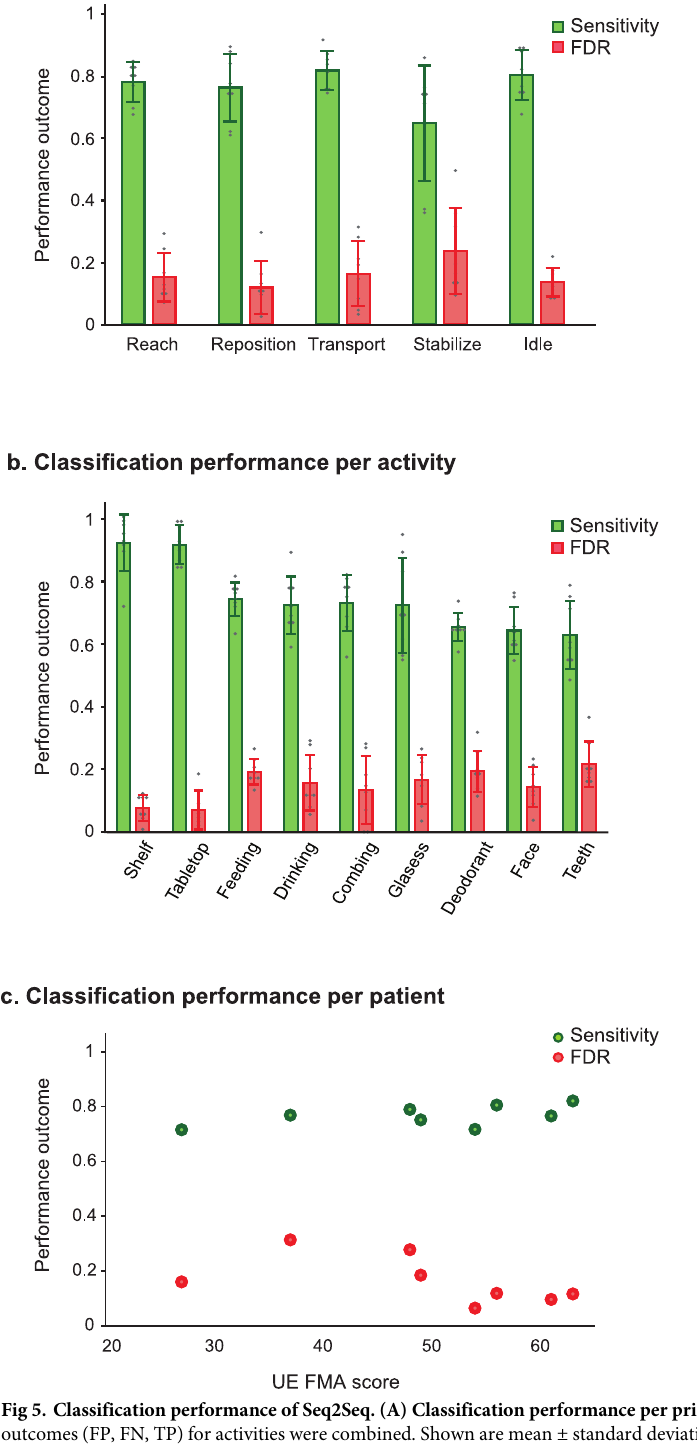
PLOS Digital Health | https://doi.org/10.1371/journal.pdig.0000044 June 16,